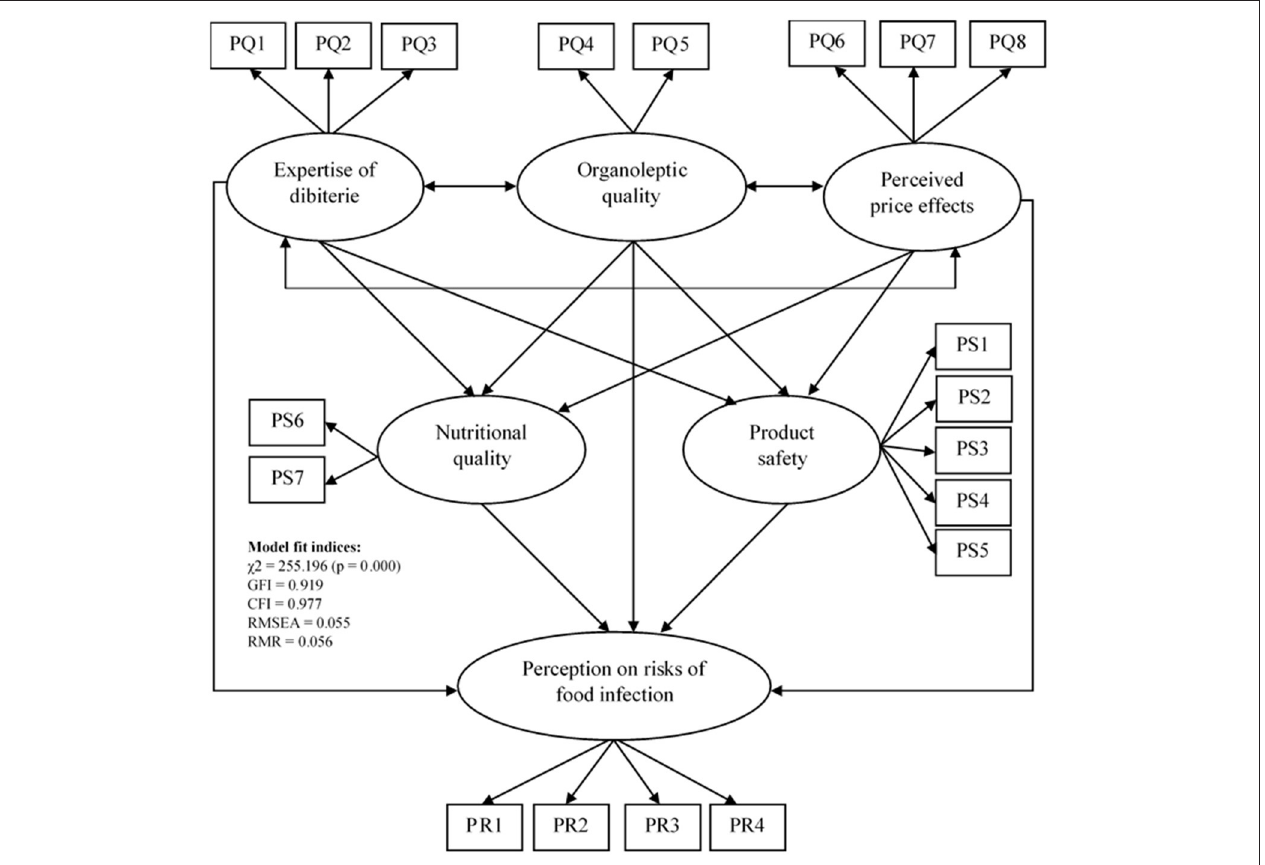
FIGURE 1 | Hypothetical relationships between the latent variables of the perception on the quality, the perception on the safety of dibiterie meat, and the perception on the risks of food infection (PQ, Perception on the quality; PS, Perception on the safety; PR, Perception on the risks).